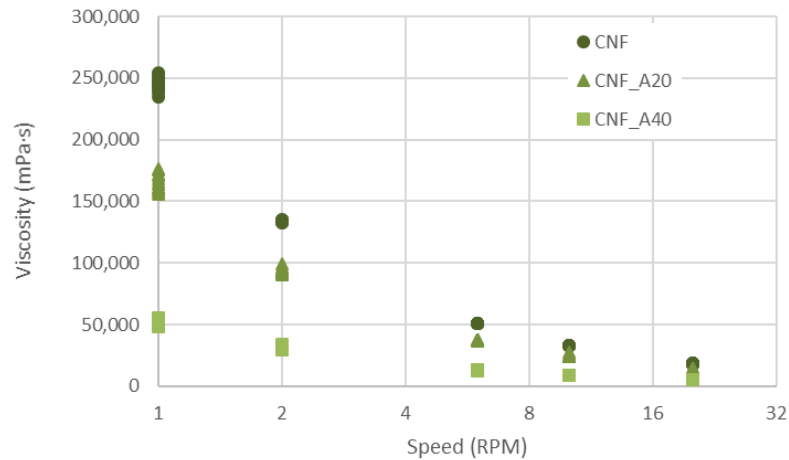
Figure 1. Viscosity of the inks CNF, CNF_A20 and CNF_A40. Ten single measurements are included for each speed interval and for each sample.